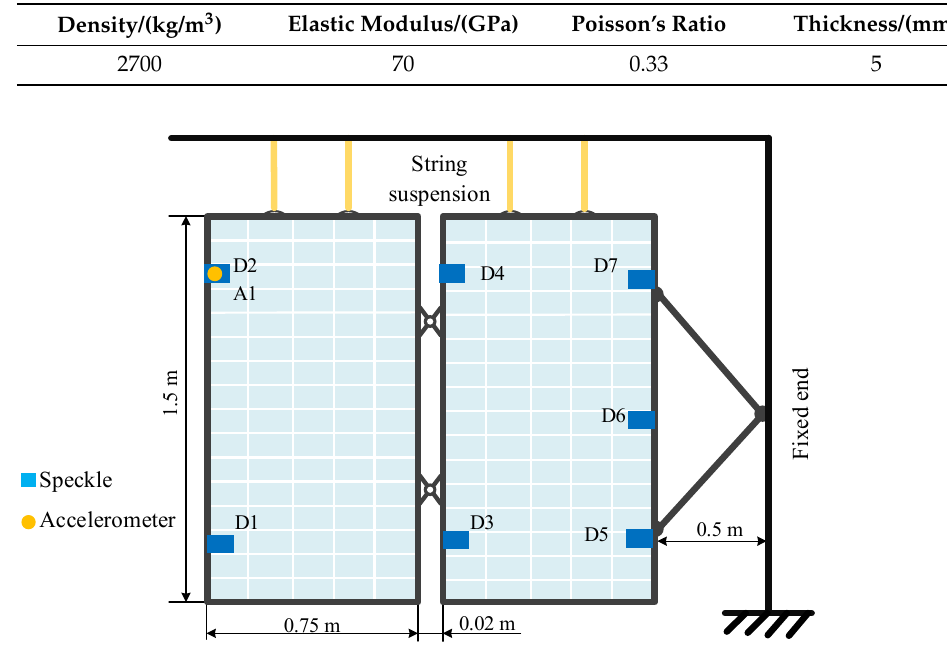
Figure 4. Dimensional drawing of ultralow-frequency flexible solar wing array with the speckle pasting position and the camera placement